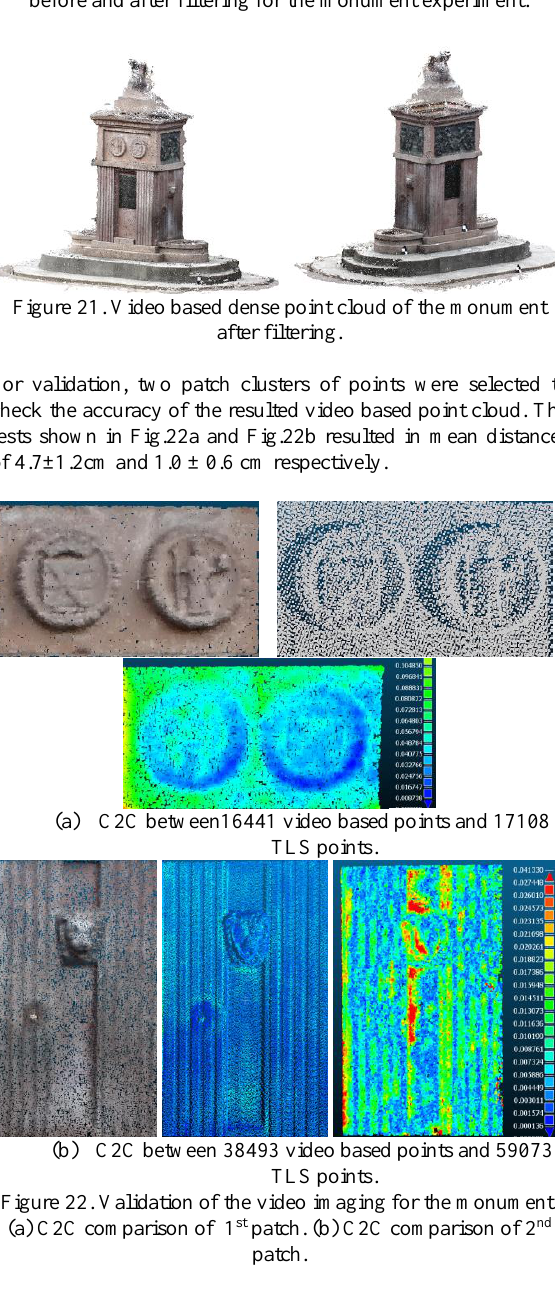
Figure 23. The still imaging network of the monument.